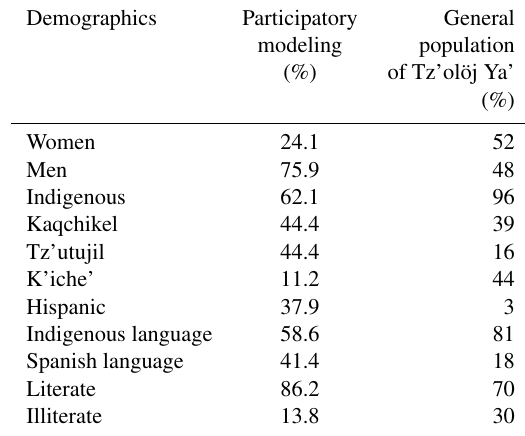
Table 1. Demographics of project